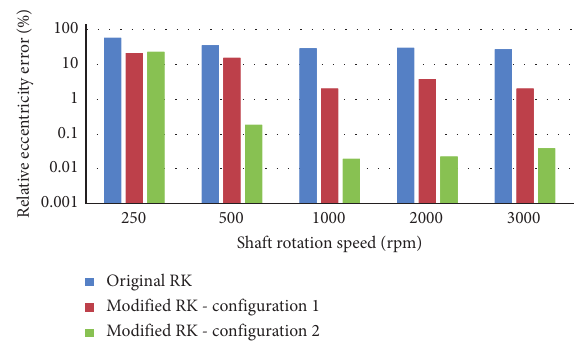
Figure 12: Difference between measured and 2D adiabatic model relative eccentricities for different test rigs (logarithmic scale).